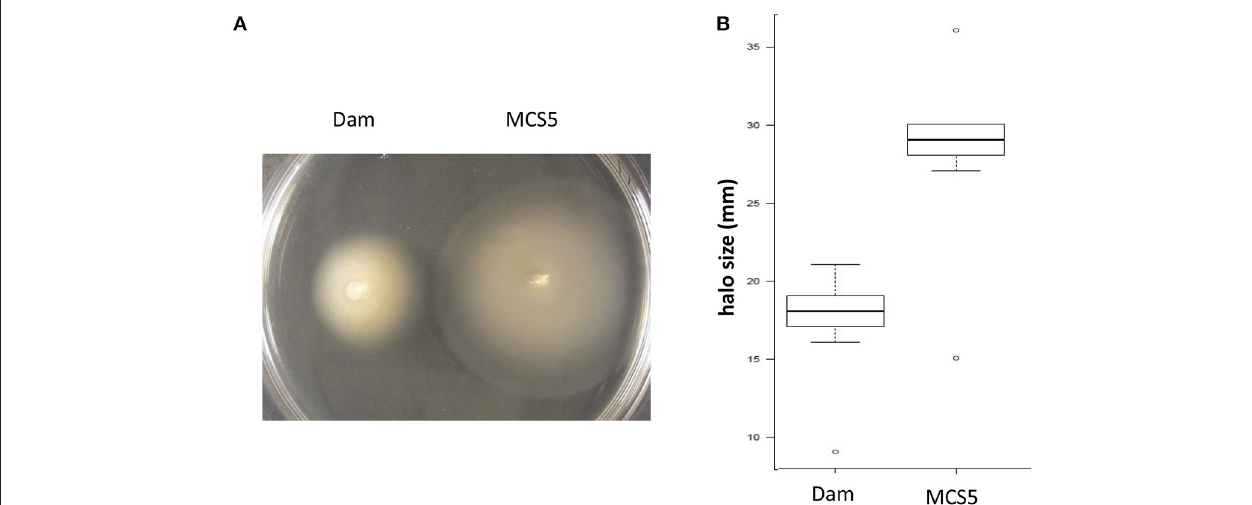
FIGURE 3 | Swimming motility of P. luminescens overexpressing dam gene (Dam) and control (MCS5). (A) Swimming halos were observed on low agar LB medium inoculated by 5 µ L of exponentially growing cells. (B) Boxplots of the diameter of the halo size of motility of each strain measured after 30 h of incubation (see Methods section for details). Difference between the two strains is significant ( p < 0.001, Wilcoxon test).